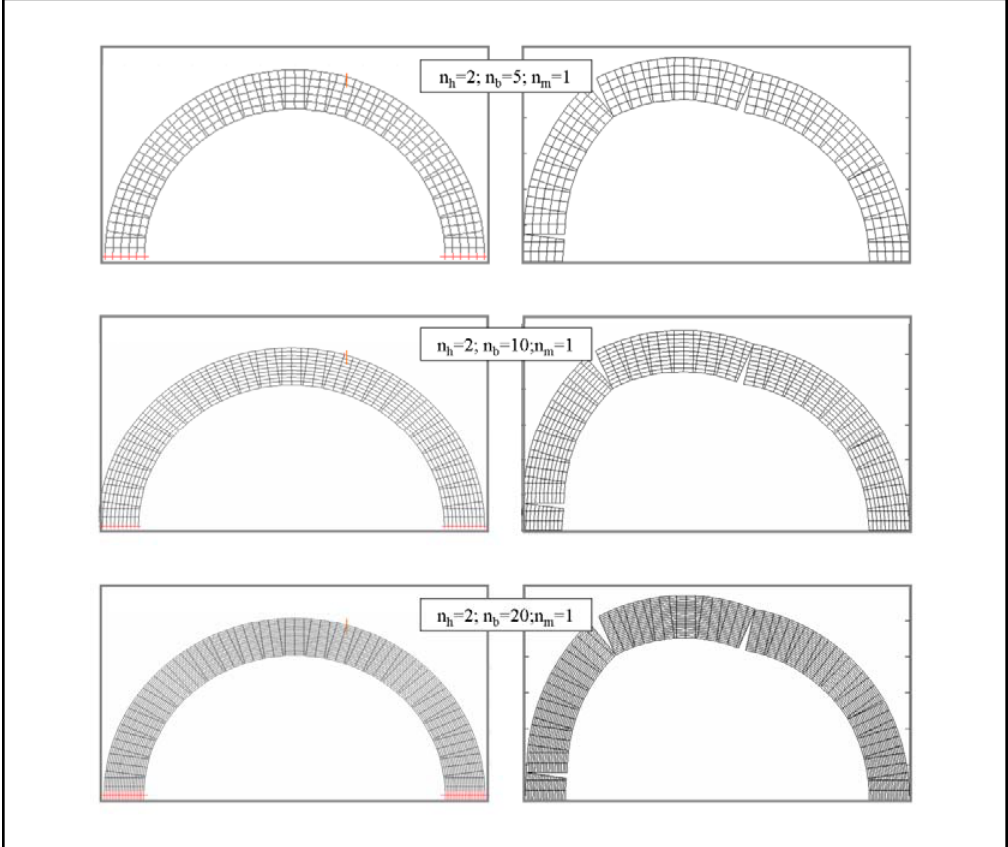
Figura 14: a) configurazione indeformata; b) configurazione deformata.